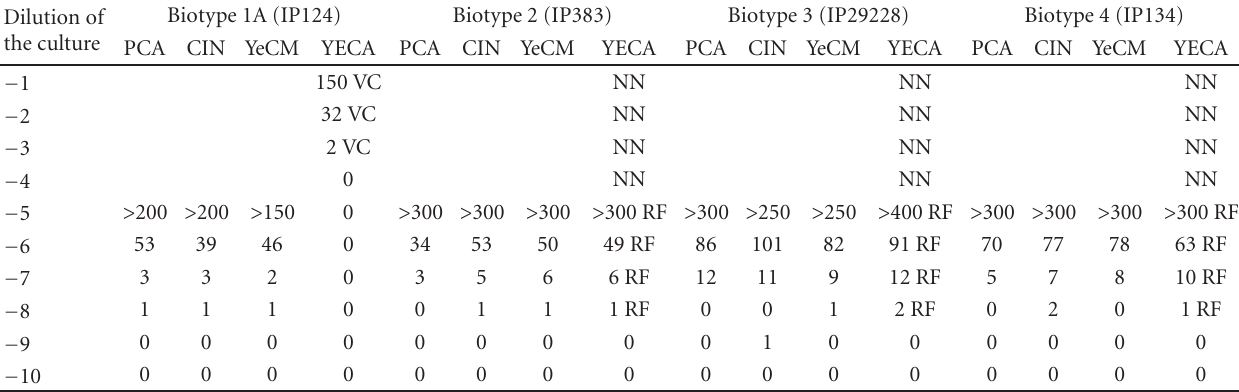
VC: violet colonies; RF: red fuchsia colonies; NN: